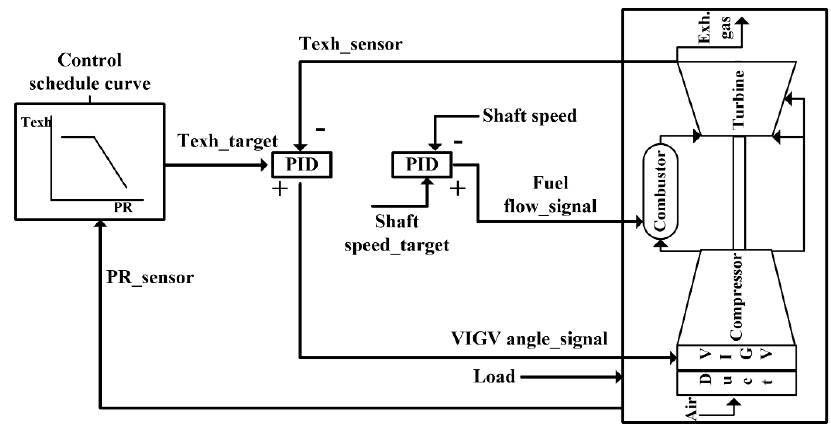
Figure 6. Conventional schedule-based control logic.